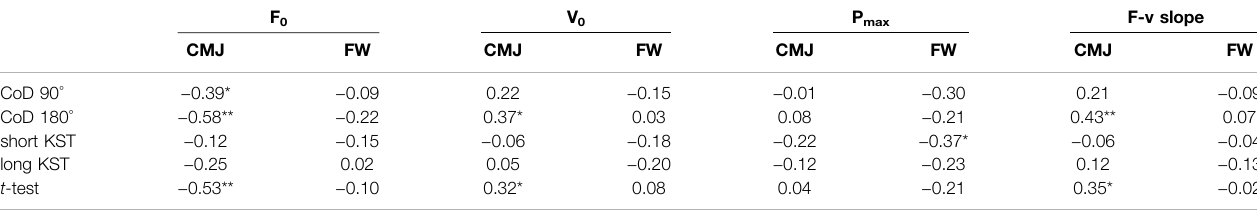
TABLE 3 | Correlation between CoD tests and Force-velocity outcome variables calculated from countermovement jumps and fl ywheel squats.